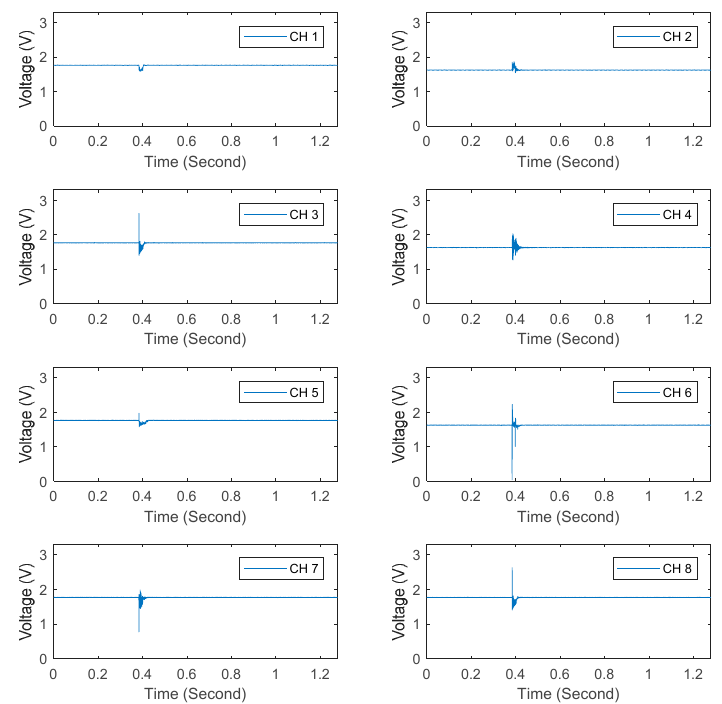
Figure 15. PZT sensor time-domain response signal (impact is introduced near No. 6 sensor).